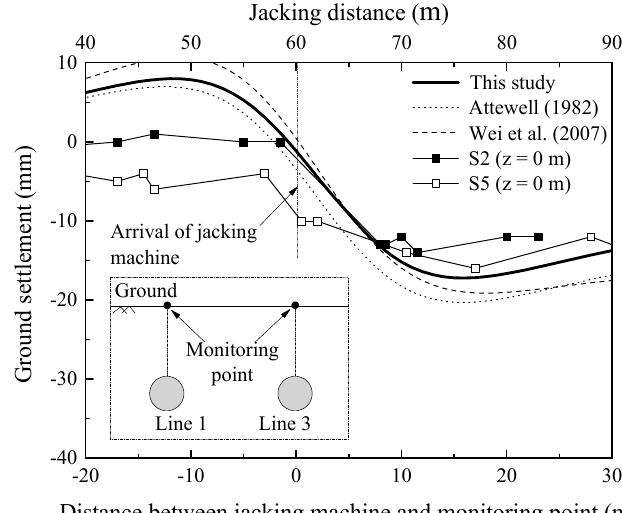
Figure 10. Ground surface settlements above Line 1 and Line 3.